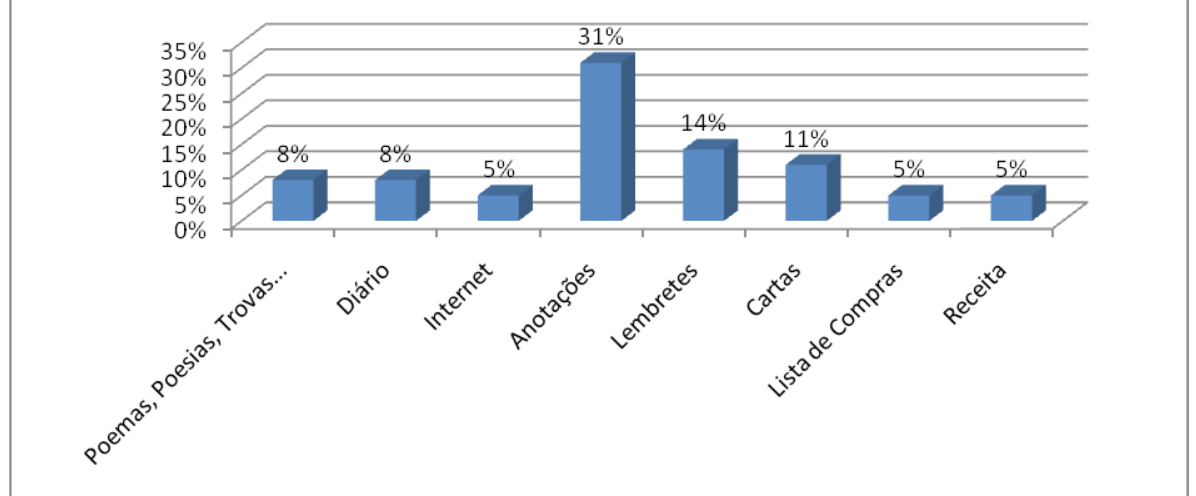
Figura 3. Materiais mais usados na